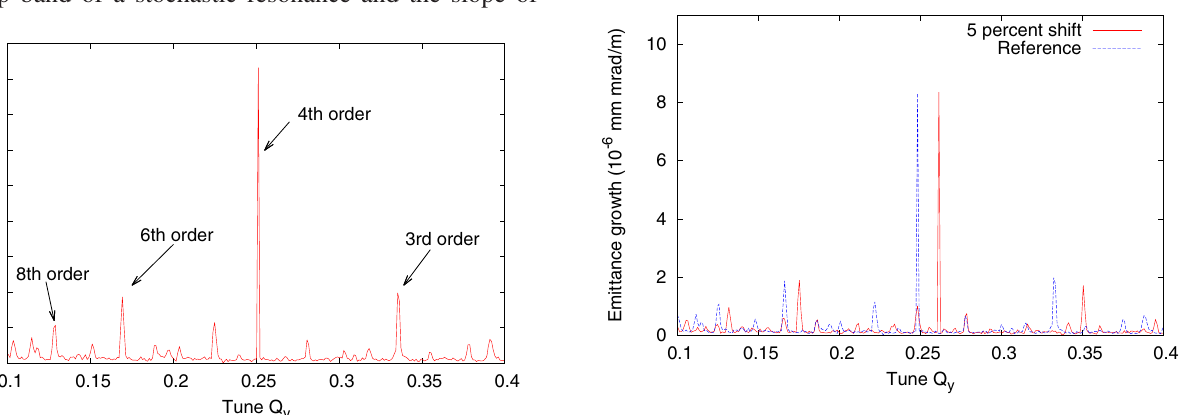
FIG. 7. Emittance growth rate for different vertical tunes Q ≃ 1 . 001 . The tune Q while Q is changed systematically in steps x y of Δ Q ¼ 0 . 001